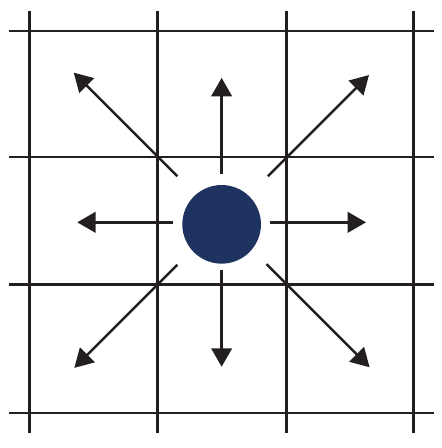
Figure 1: Moving setting and distributive